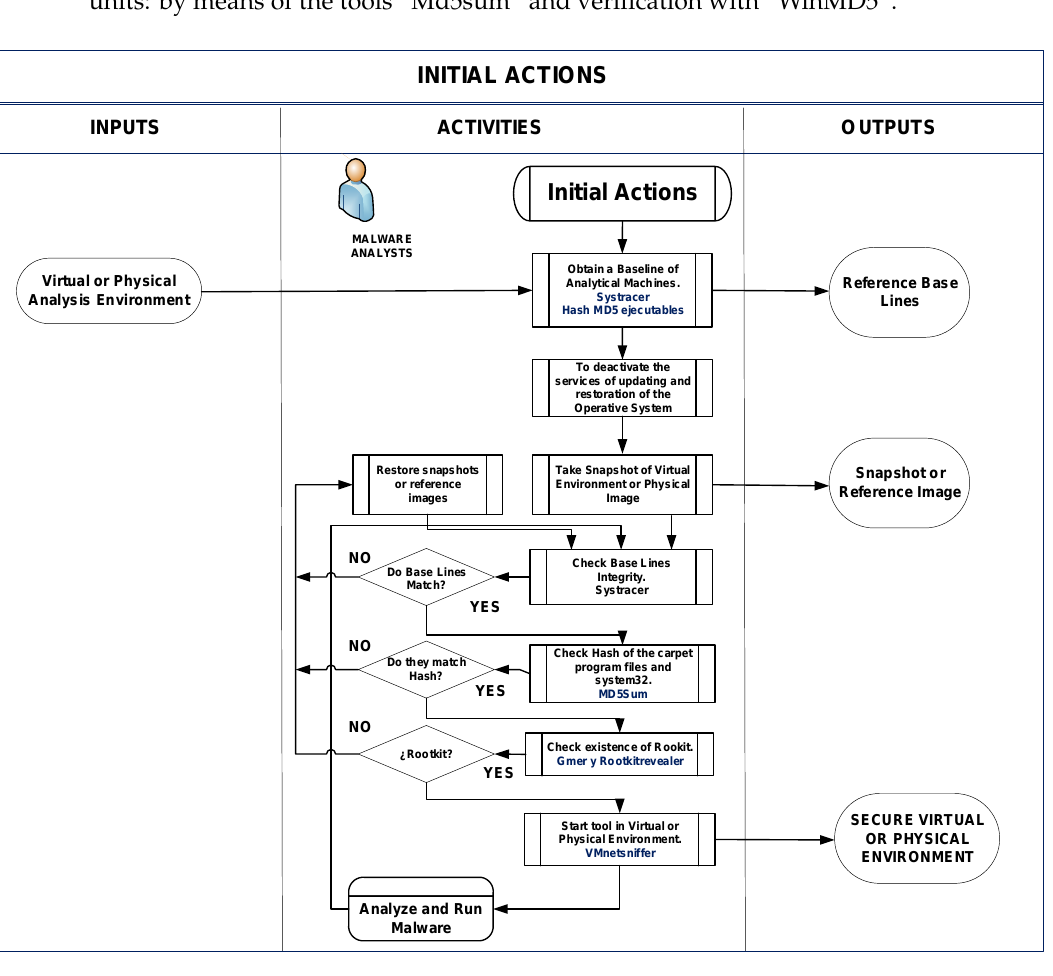
Figure 4. Diagram of the initial actions step.